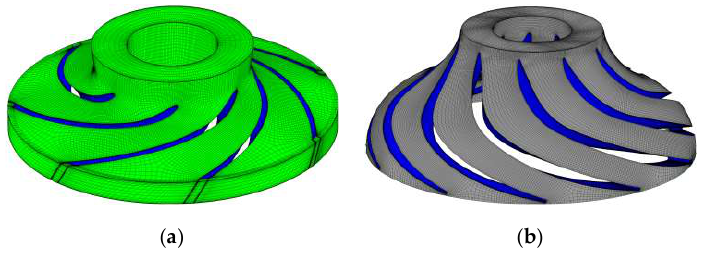
Figure 3. Mesh of main components. ( a ) Impeller; ( b ) Diffuser.